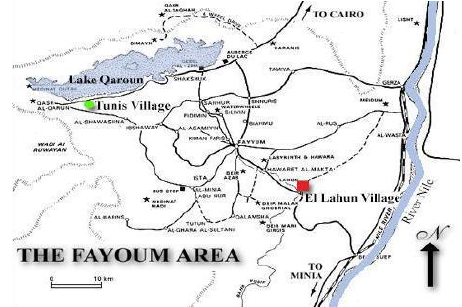
Figure 16. Sketch map of the Fayoum depression with the location of Tunis and Lahun village, Tour of Egypt Sites,